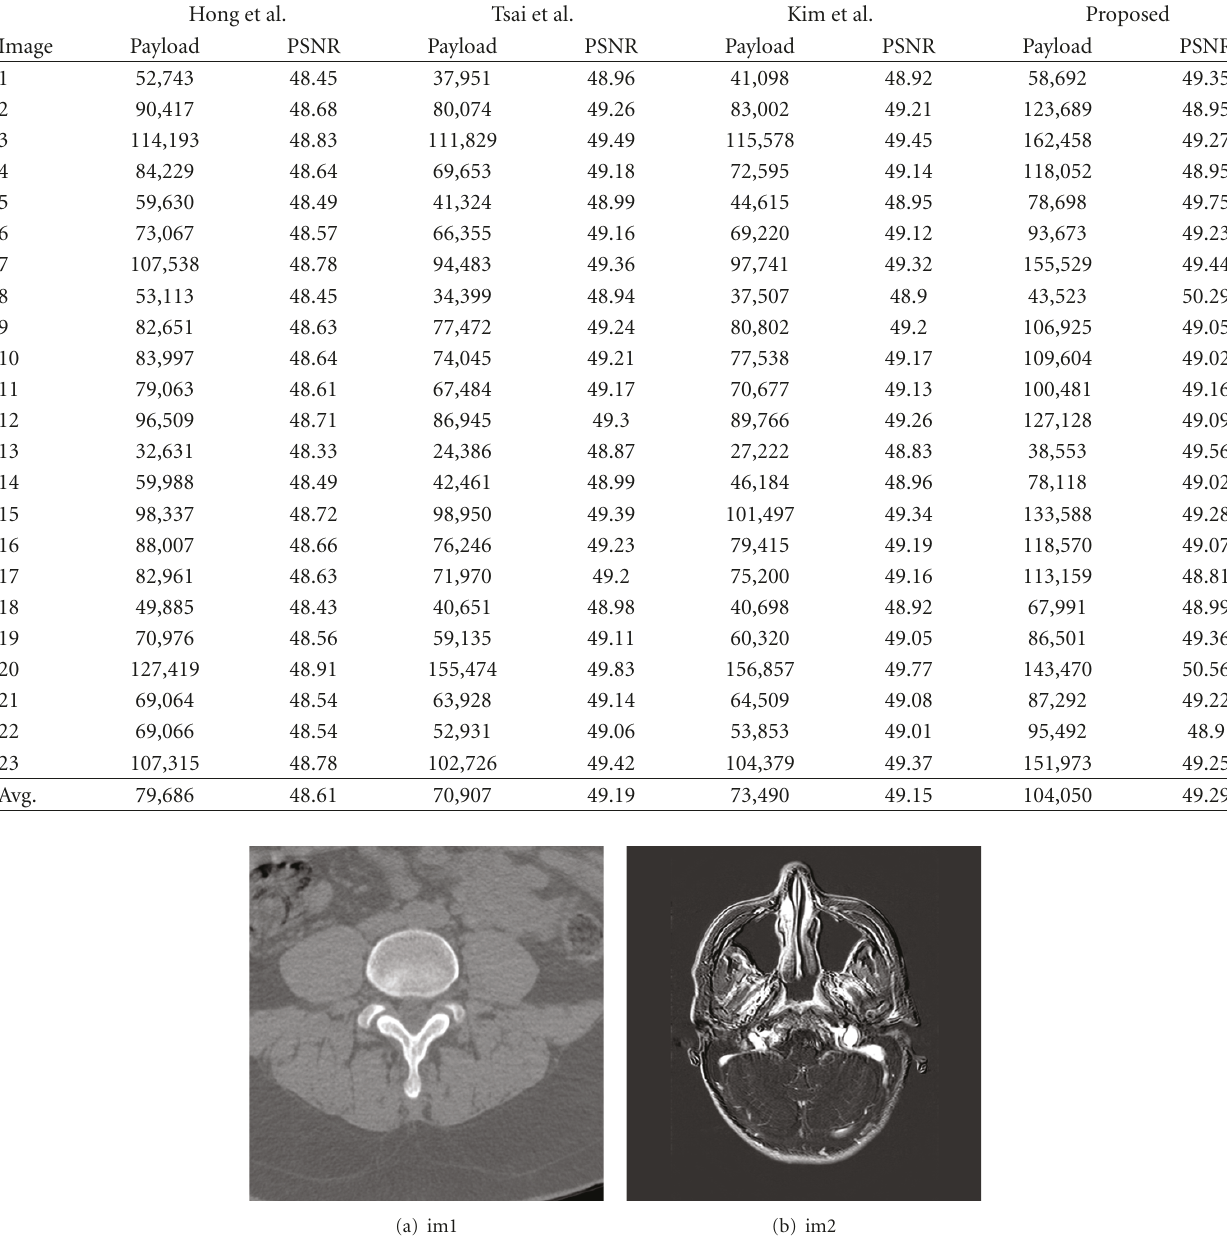
Table 2: Maximum payload for various test images (payload is measured in bits).